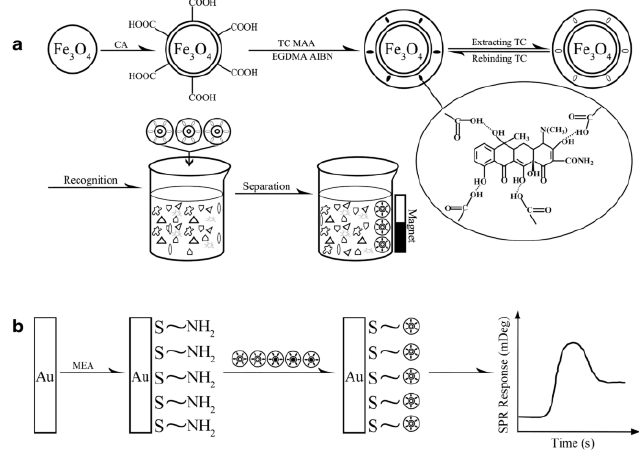
Figure 9. Schematic diagram of the synthesis of MMIP NPs for the recognition and separation of tetracycline (TC) ( a ) and MMIP NP-enhanced SPR for TC detection ( b ) [115].